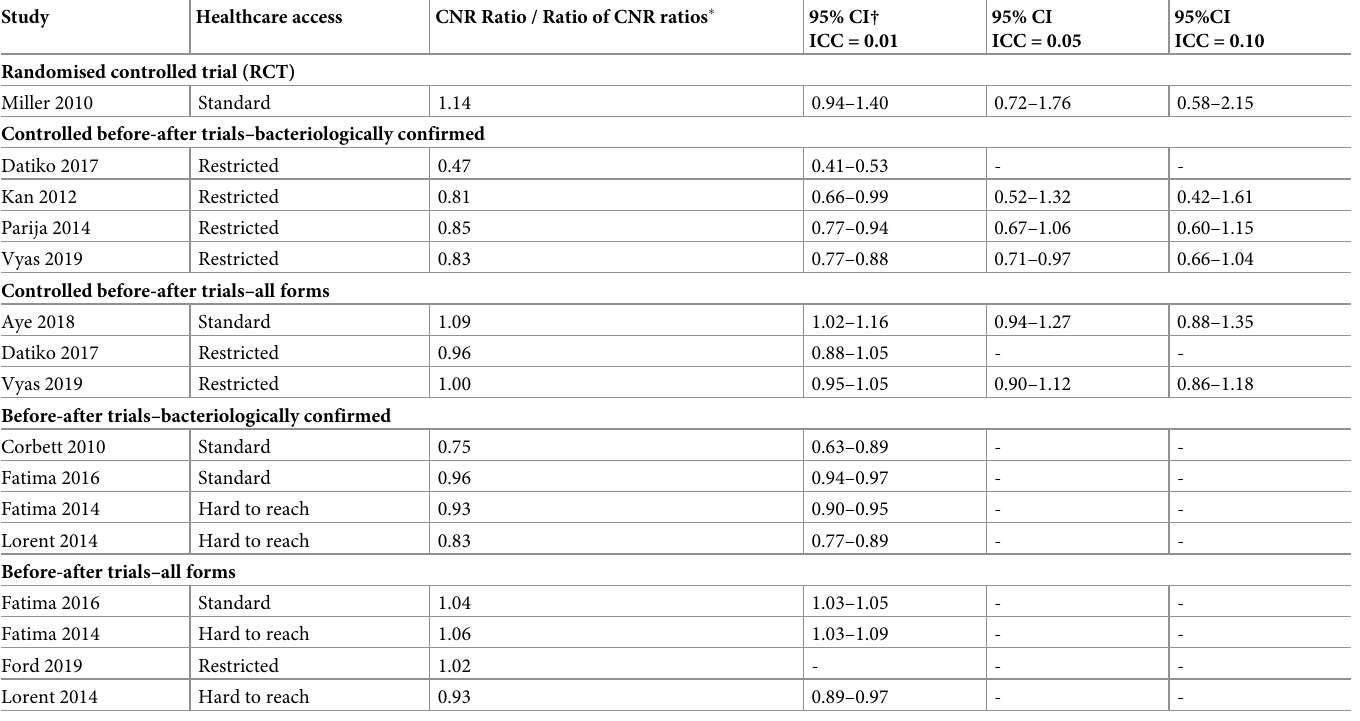
Table 2. Routinely-diagnosed TB case-notifications outcome